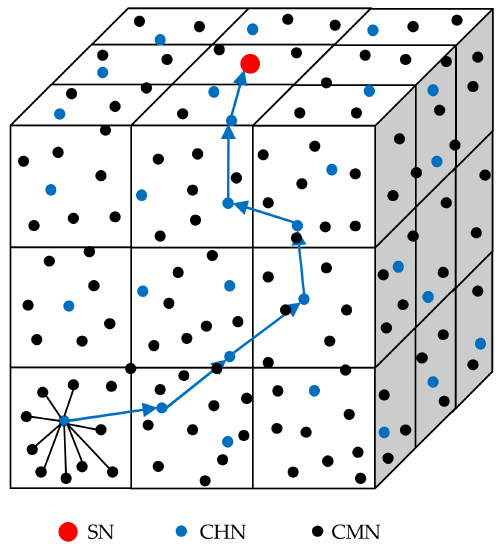
Figure 1. The schematic diagram of the network